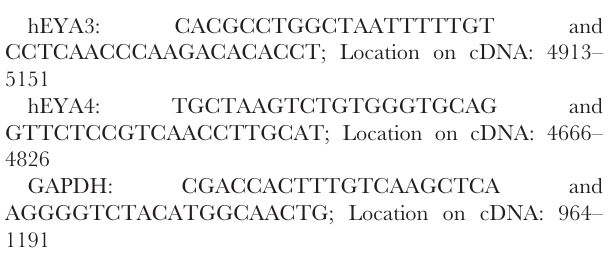
Figure 8. Dose-dependent effects of EYA inhibitors on the developing zebrafish vasculature. ( a ) Titration of compounds 1, 1a, 1b at the indicated doses. Two independent experiments were performed in most cases using 9–15 embryos per experiment at each dose; the standard error and mean values are shown. Experiments with 0.25 m M compound 1 and 5 m M compound 1b were only performed once using 10 embryos each. The y-axis shows the percentage of embryos showing any defects in vascular development (either in- tersegmental vessels (ISV) formation or defects in the dorsal aorta/ cardinal vein). ( b ) Images of representative untreated control (CTL), vehicle (DMSO) treated, and EYA inhibitor treated embryos at 28– 30 hpf. Note reduced or absent ISV in the inhibitor treated embryos relative to the controls (ISV in controls indicated by white arrows).